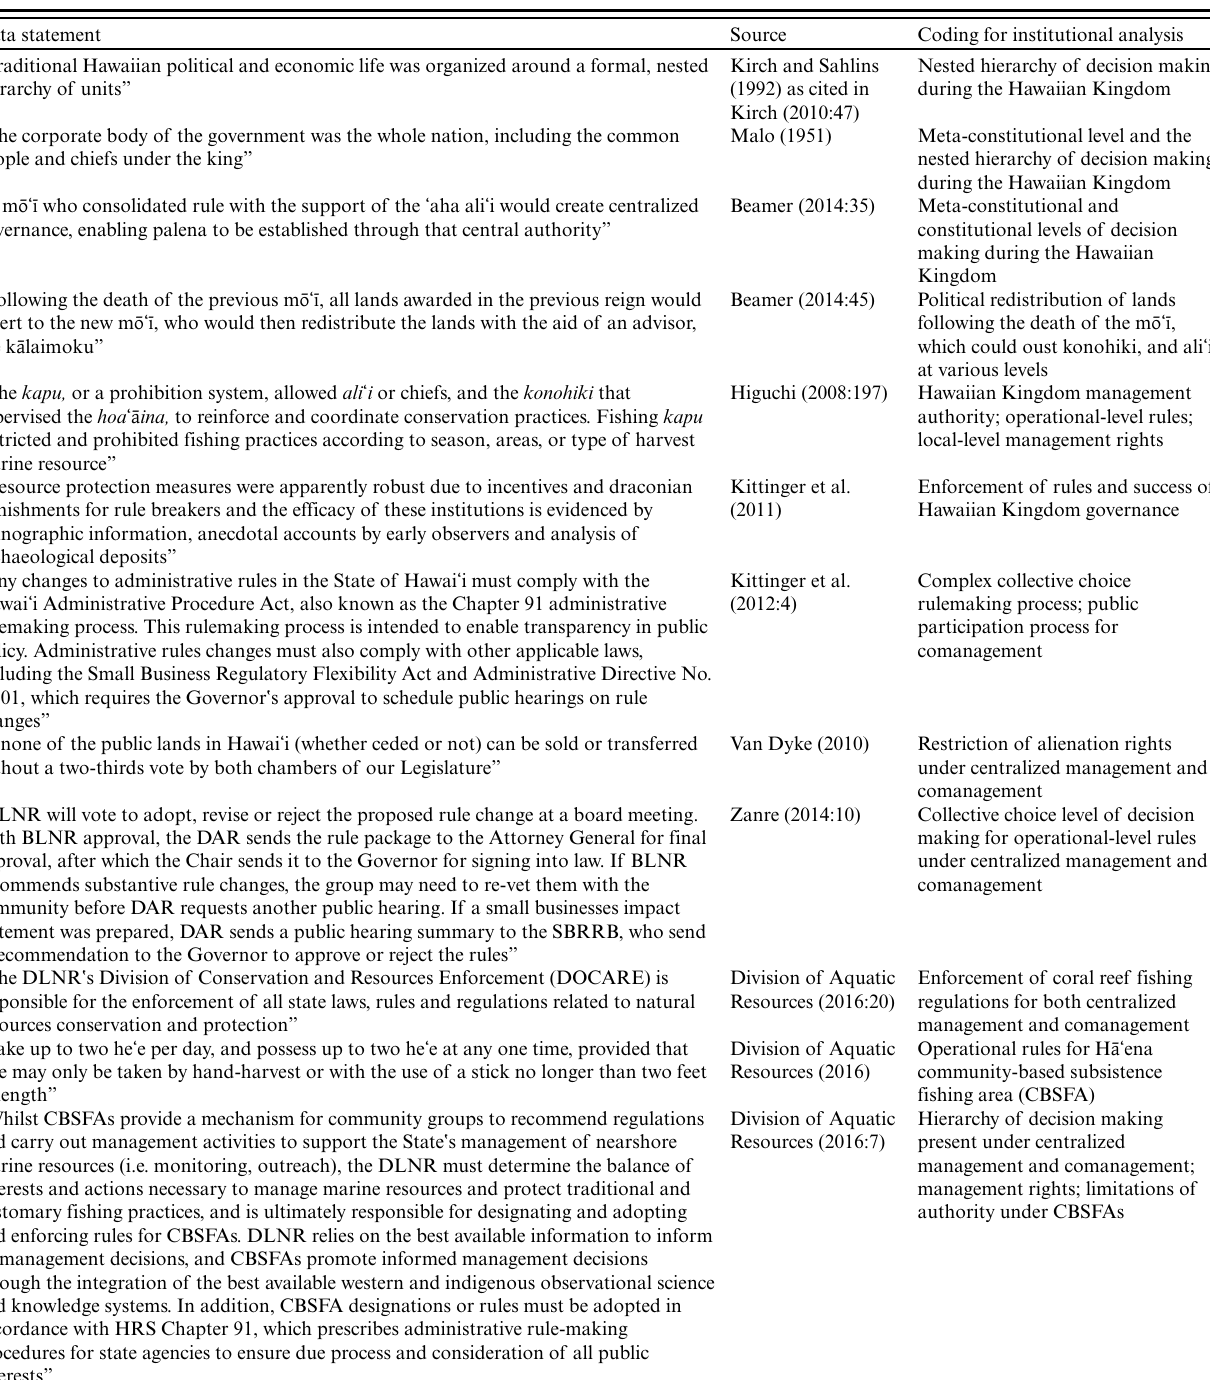
Table 2. Examples of data sources and coding used to inform institutional